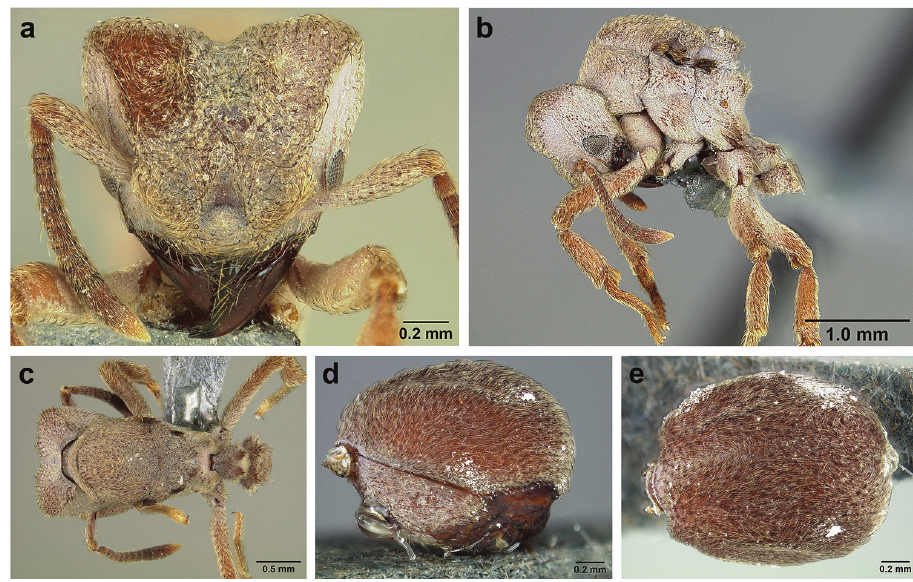
Figure 34. S. maravalhas queen (USNMENT00924082). a Head b lateral profile c mesosoma, dorsal view; and gaster d lateral and e dorsal